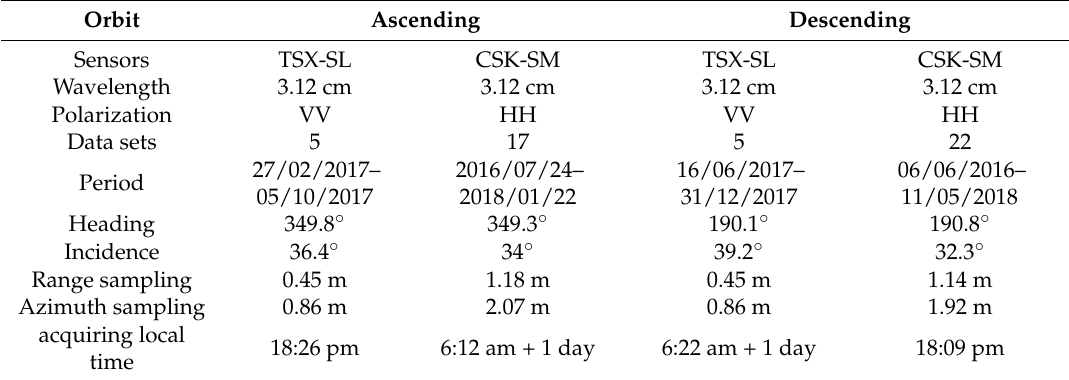
Table 1. The main parameters of the ascending and descending TSX-SL and CSK-SM